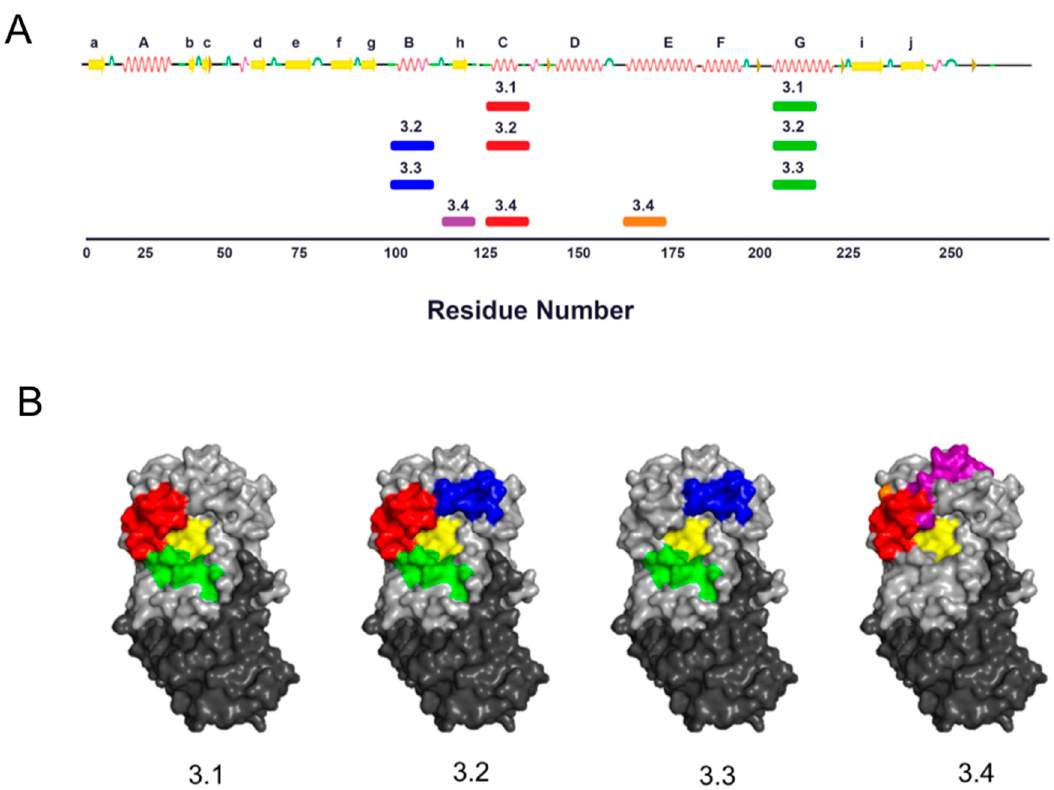
Figure 10. Visual representation subcluster 3 binding sites on ricin toxin. ( A ) Linear depiction of RTA with arrows denoting β -strand secondary structure and coils indicating α -helices, as per Protein Data Bank (PDB) format. Below, the colored bars denote epitope coverage for each of the V H H subclusters 3.1–3.4. The colors correspond to secondary structures highlighted in panel B. Horizontal line below refers to RTA amino acid residue number. ( B ) Surface representations of ricin (PDB 2AAI) using PyMol showing the regions of protection for each of the four subclusters (3.1–3.4). Colors are as follows: RTA, light gray; RTB, dark gray; active site, yellow; α -helix B, blue; α -helix C, red; α -helix G, green; α -helix E, orange; β -strand h, purple.